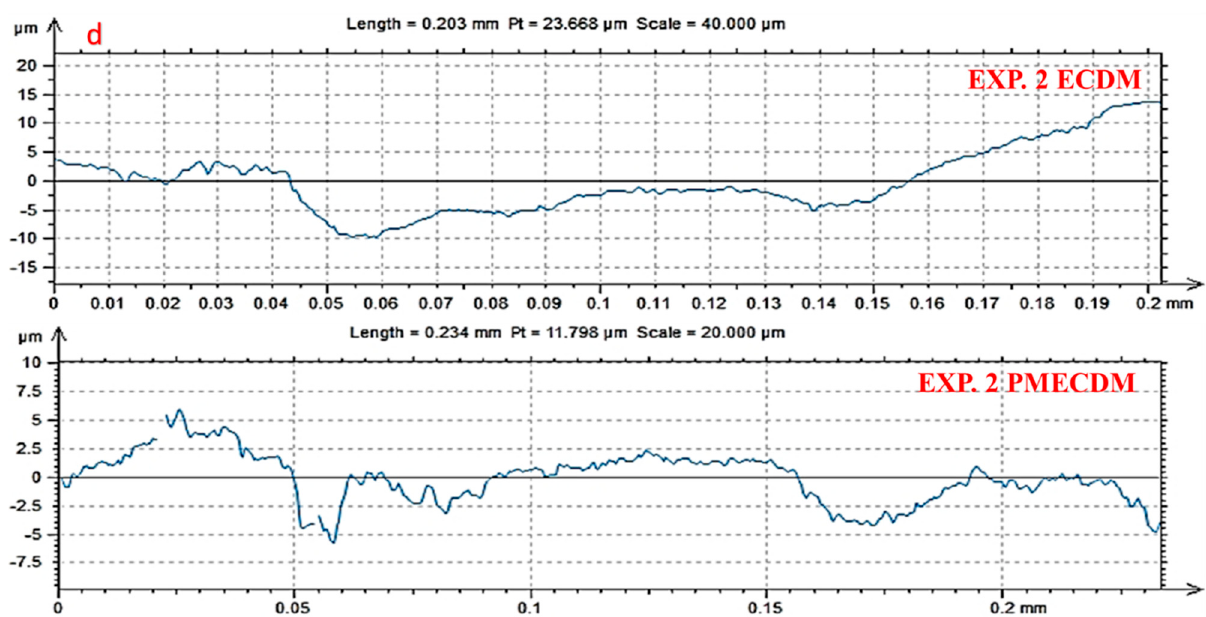
Figure 4. Effect of applied voltage on average surface roughness at different ( a ) duty factors, ( b ) voltages and ( c ) electrolyte concentrations, ( d ) surface profile of both the processes with same input parameters (D: duty factor for MECDM, PD: duty factor for PMECDM, C: electrolyte concentration for MECDM, PC: electrolyte concentration in PMECDM).